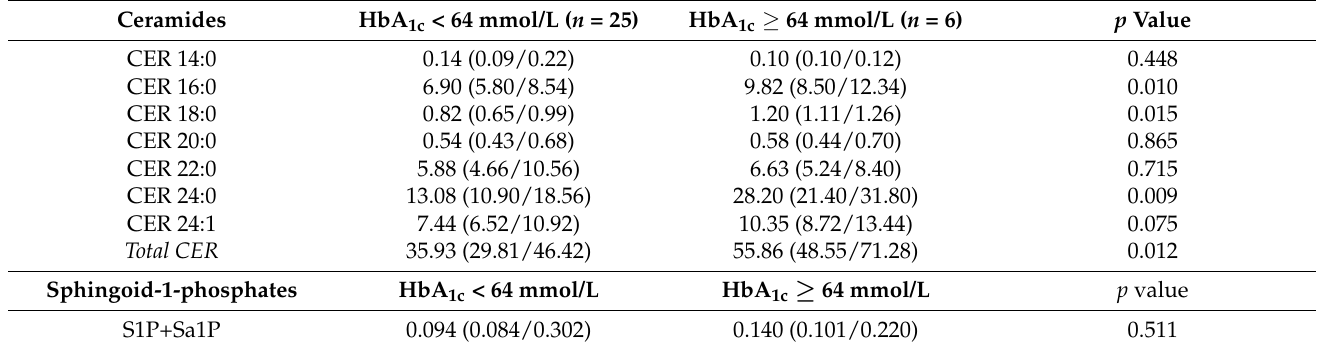
Table 4. Placental concentrations of ceramides and lysosphingolipids in pregnancies complicated by T1D or T2D categorized into those with good or poor glycemic control according to HbA 1c concentration before